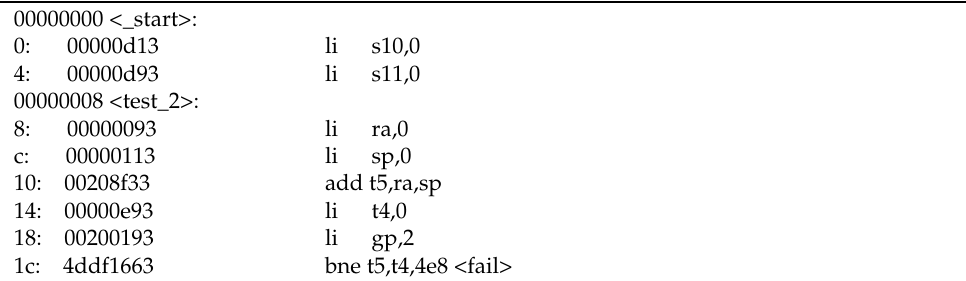
Code 1. rv32ui-p-add partial assembly code example-1.